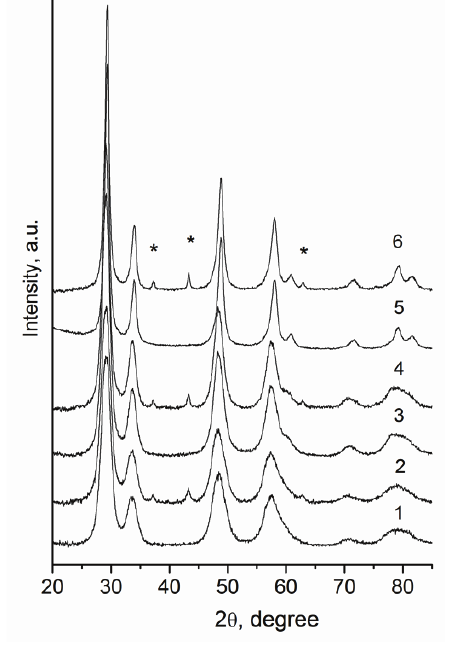
Figure 1: Powder XRD patterns of Ce-Zr supports (1, 3, 5) and Ni-